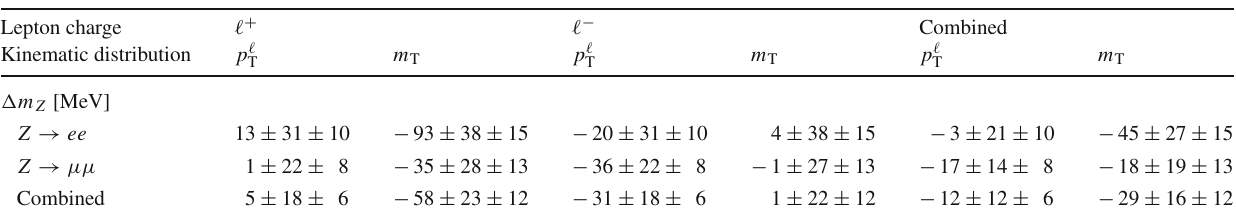
Table 7 Difference between Z -boson mass, extracted from p (cid:7) distributions, and the LEP combined value. The results are shown sepa- rately for the electron and muon decay channels, and their combination. The first quoted uncertainty is statistical, the second is the experimental